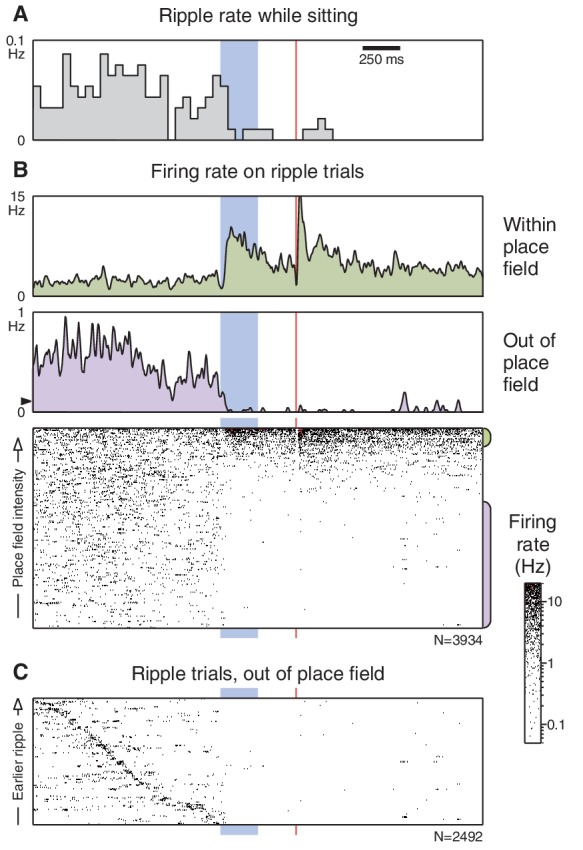
Ripples cease following the CS onset.(A) Ripple occurrence rate during trials presented while the animal was sitting (ripples did not occur when the animal was running). (B) Unit responses on trials where a ripple was detected prior to the CS onset. Layout is similar to Figure 3B, but note the difference in scale for the 'out of place field' peri-event firing rate. The black triangle marks the average pre-trial firing rate from the corresponding panel in Figure 3B. (C) 'Out of place field' rasters sorted by the time that the ripple occurs. Some trials had more than one ripple; for these the longest ripple was used.